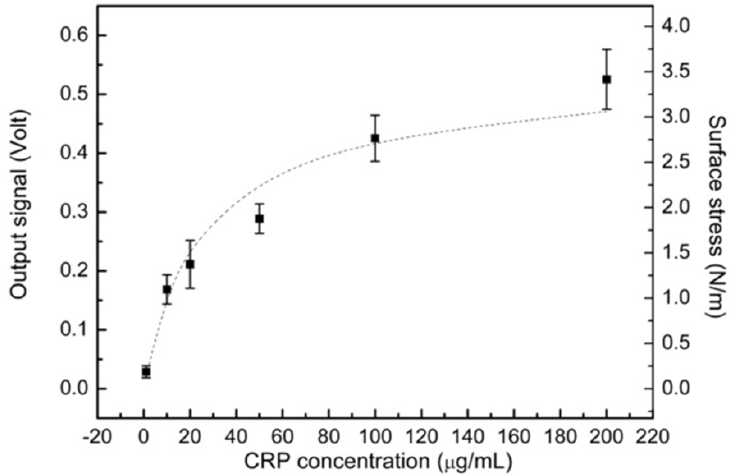
Figure 5. Immunoassay reproducibility and binding affinity investigation with respect to CRP concentrations measured by the electrical detection with single free-standing, thermally stable piezoresistive microcantilever